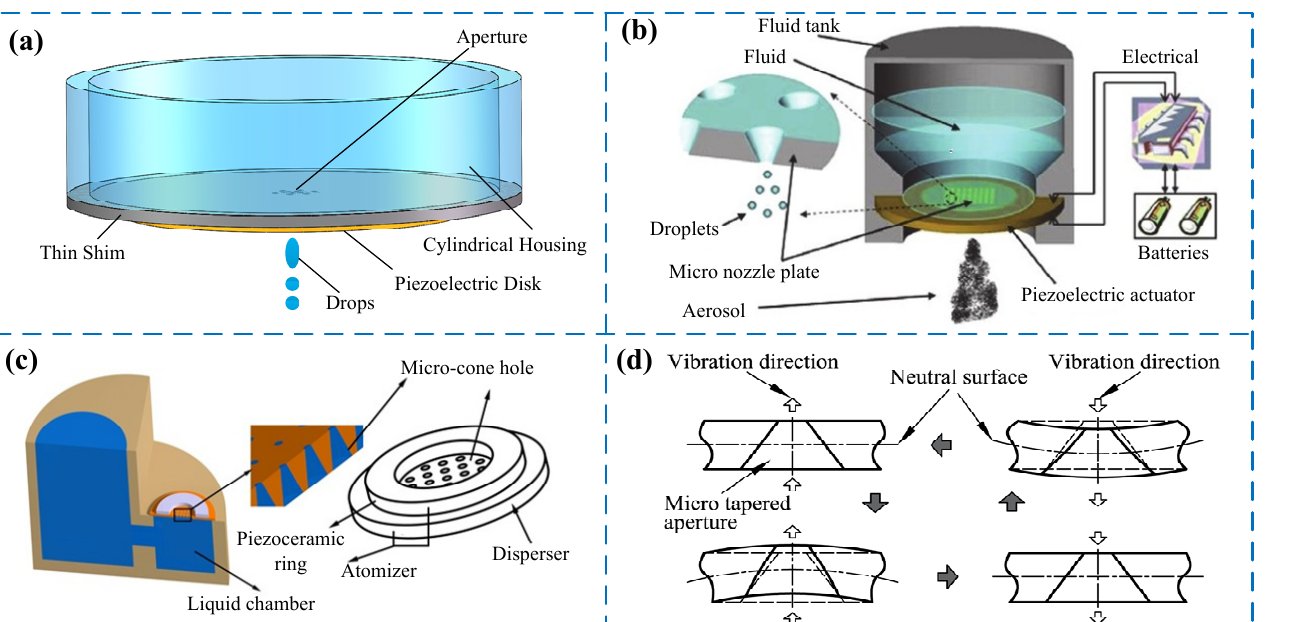
Table 3. Summary of properties for the dynamic mesh atomizer.